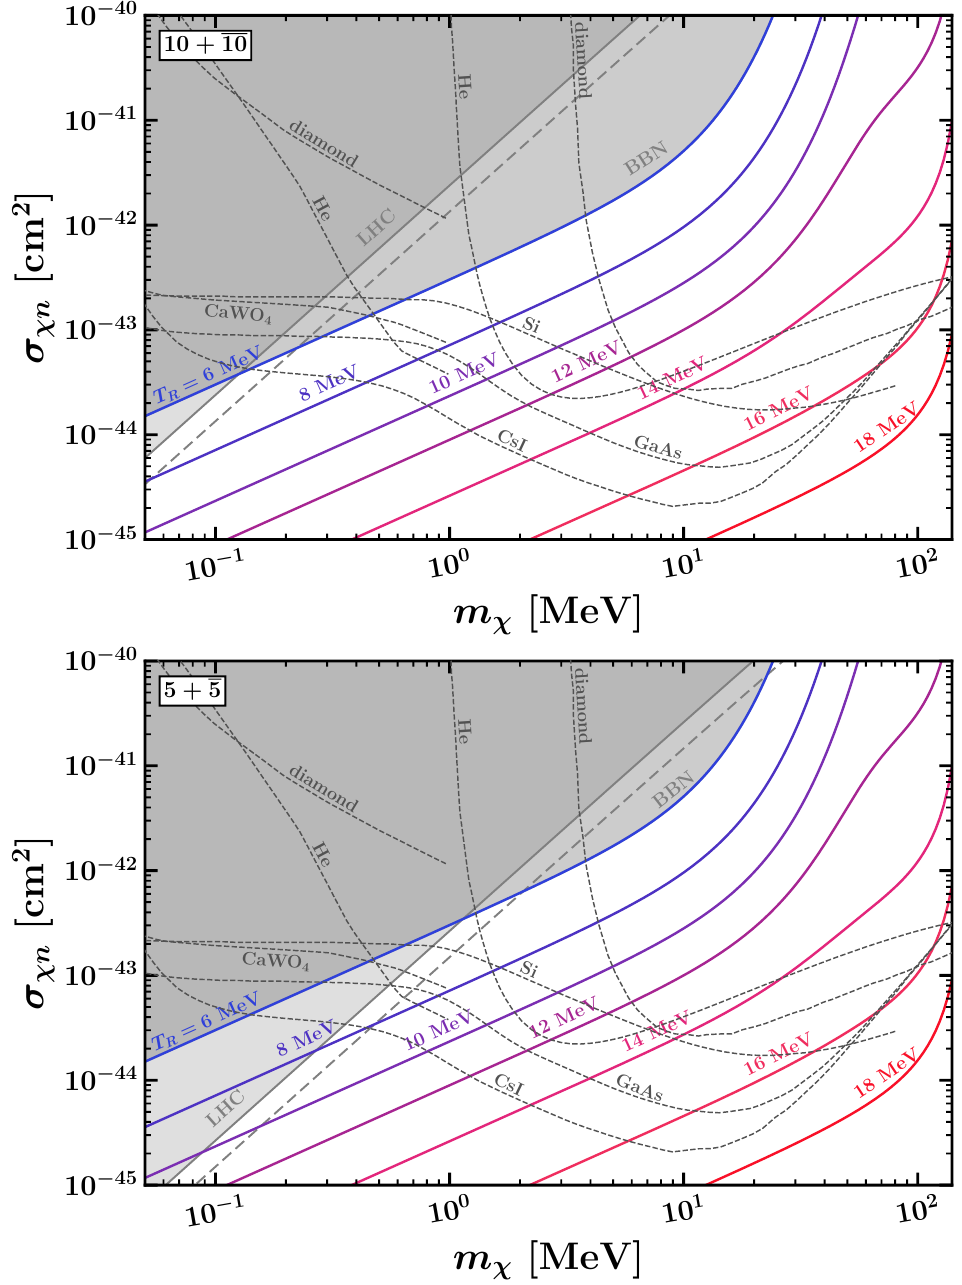
Figure 7 . The dark matter-nucleon cross section σ χn as a function of dark matter mass m χ for y ψ = y χ = 1 . For reheating temperatures shown, each colored contour yields the correct dark i matter abundance for heavy TeV-scale vectorlike fermions in the 5 + 5 (top panel) and 10 + 10 (bottom panel) representations of SU (5) , see text for additional simplifying assumptions. The gray shaded regions are excluded by the LHC and BBN, while the dashed gray lines show the projected sensitivities of future experiments [5, 10, 12–14, 16,